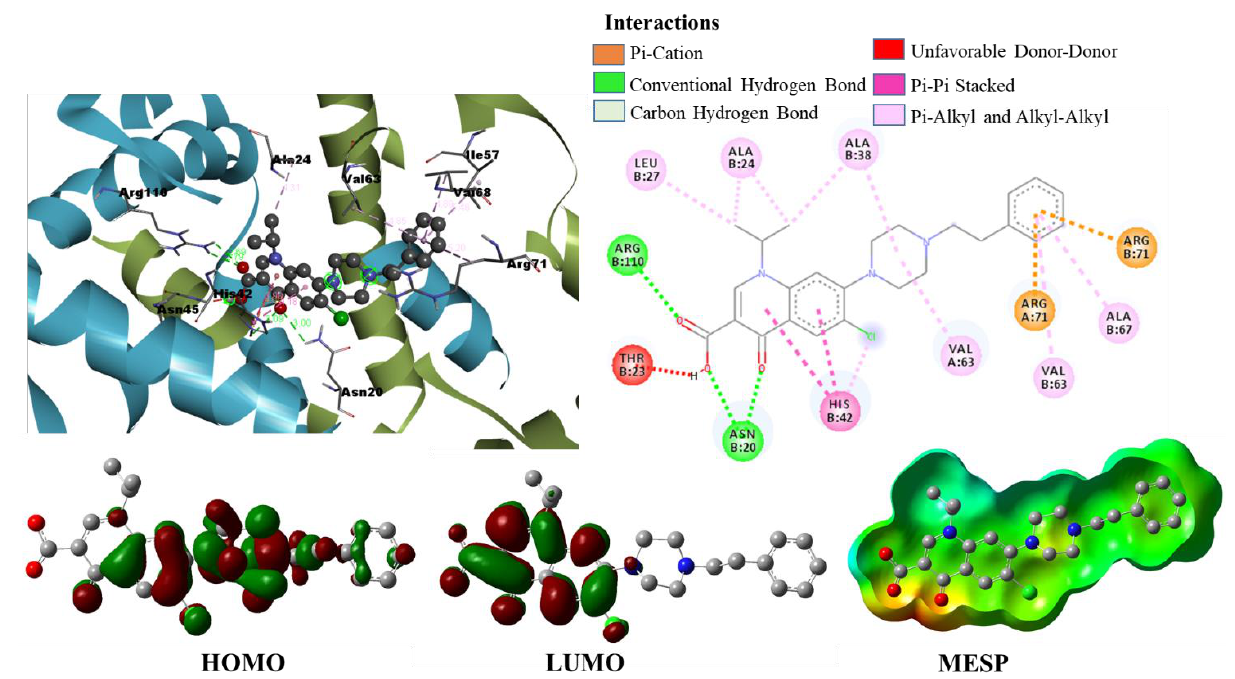
Figure 11. Binding mode conformation and molecular interactions of compound Mol34 in the active site of S. epidermidis TcaR. The left and right figures represent the molecular interactions in 3D and 2D, respectively. The hit compound is shown in the ball-stick model, and the key interacting residues are shown as grey sticks. Isodensity plots of HOMO and LUMO and molecular electrostatic potential of hit compound.